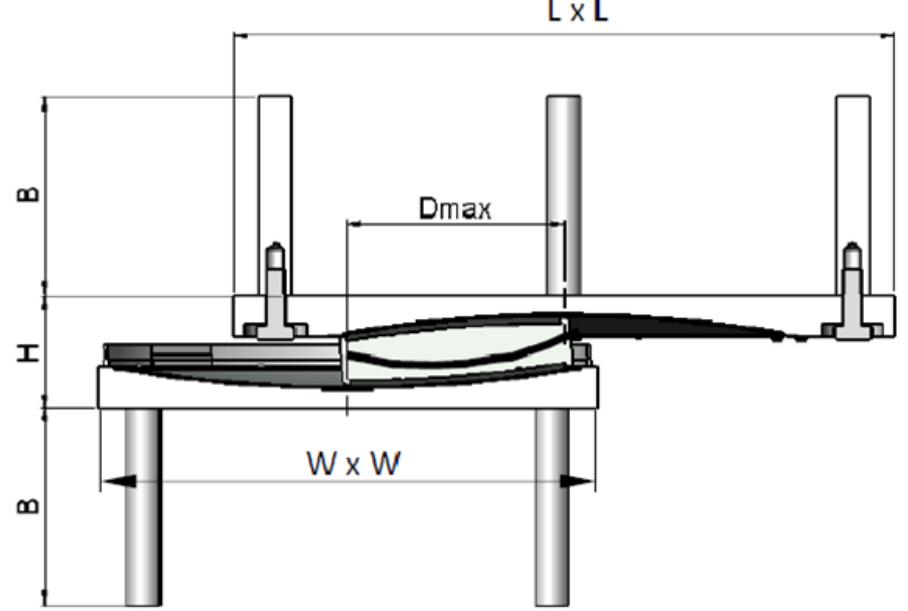
Figure 7. Indicative slider dimensions: L = 1,53 m; W = 1,08 m; B = 0,3 m; H = 0,17 m; D max = 0,6 m [37].